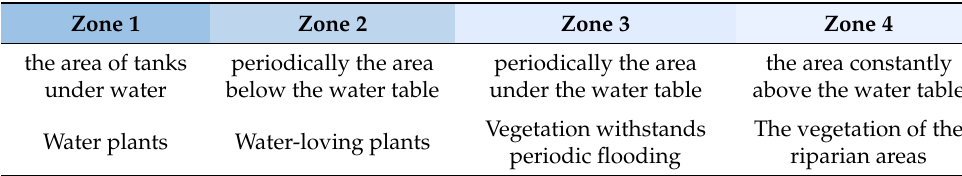
Table 4. Bioretention zones with their vegetation.